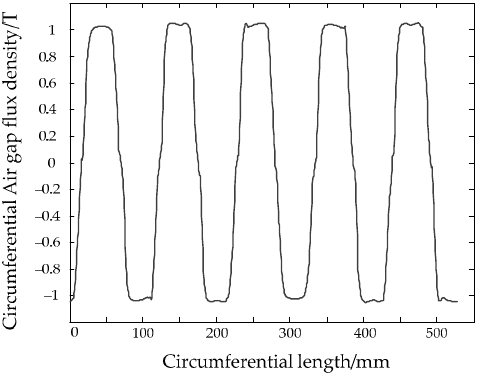
Figure 5. The curve of no-load flux density of yokeless and segmented armature axial flux motor.